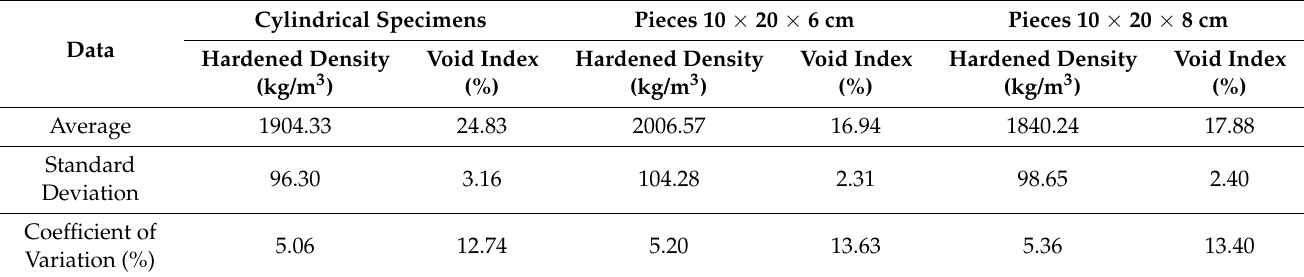
Table 8. Results of hardened density and voids index of RCA-based pervious concrete.